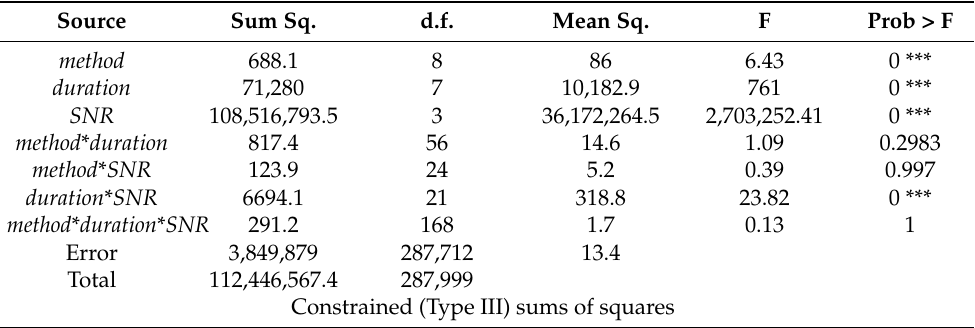
Table A1. Three-way ANOVA tests were performed to investigate the effects of the three factors on both, mean and median frequency. The three factors used are method (Welch and orders of Burg), duration (T varying from 250 to 2000 ms) and SNR (from 5 to 20 dB). Their interaction effects are showed from the 4th to the 7th row of the table. The significance levels were set at: * p < 0.05, ** p < 0.01, *** p < 0.001. All the values less than 2 × 10 − 16 were indicated as 0, with the corresponding significance indicated by *** p < 0.001.